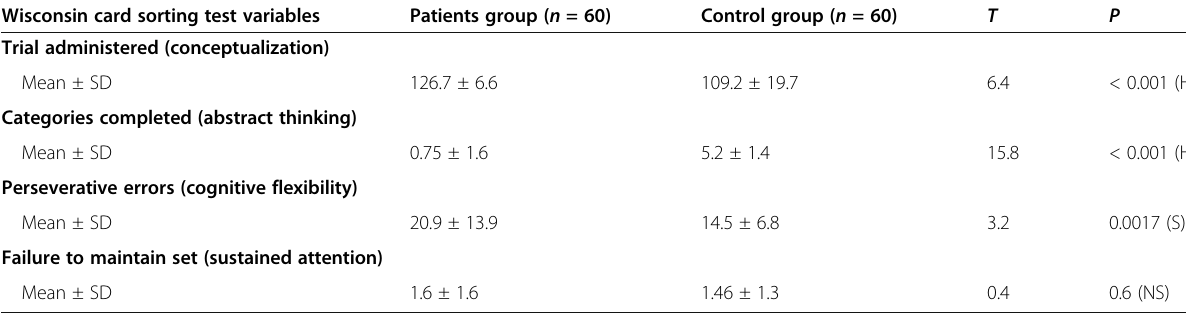
Table 4 Assessment of executive function by Wisconsin card sorting test Wisconsin card sorting test